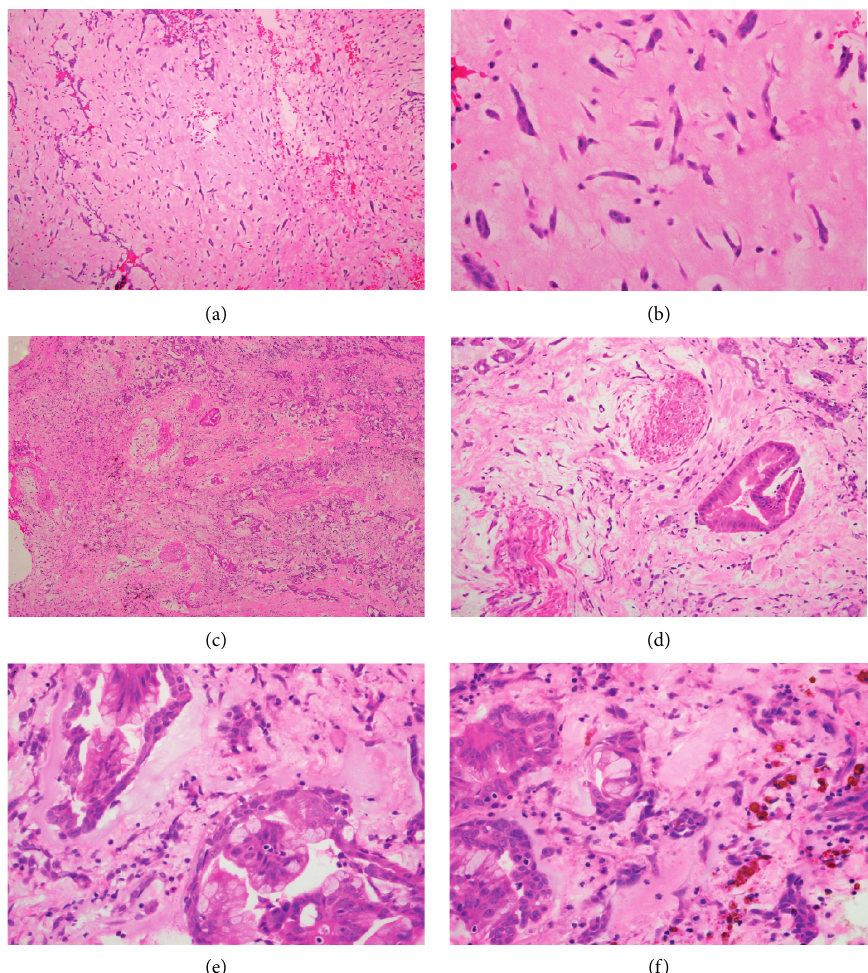
Figure 3: Hematoxylin and eosin stain showing the more typical cardiac myxoma cells with abundant eosinophilic cytoplasm and bland nuclei (a, b) and areas with glandular differentiation composed of bland columnar cells with basal nuclei and apical mucin (c–f). Myxoid stroma is obvious in both components, with occasional hemosiderin deposits (f) (original magnifications × 40 (c), × 100 (a), × 200 (d), and × 400 (B & E-F)).